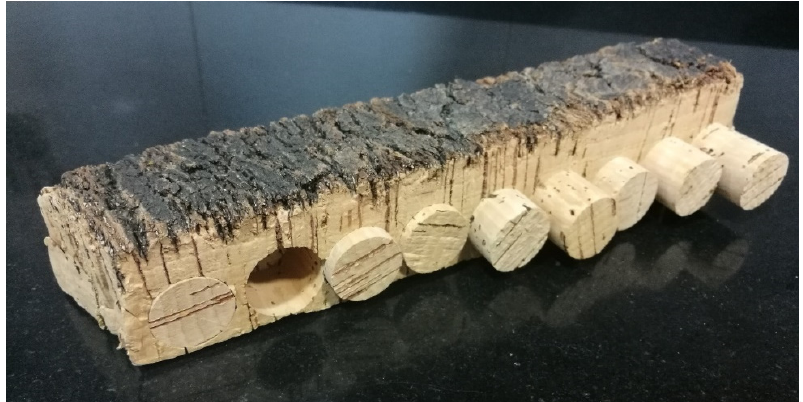
Figure 3. Punched cork stoppers (Source: